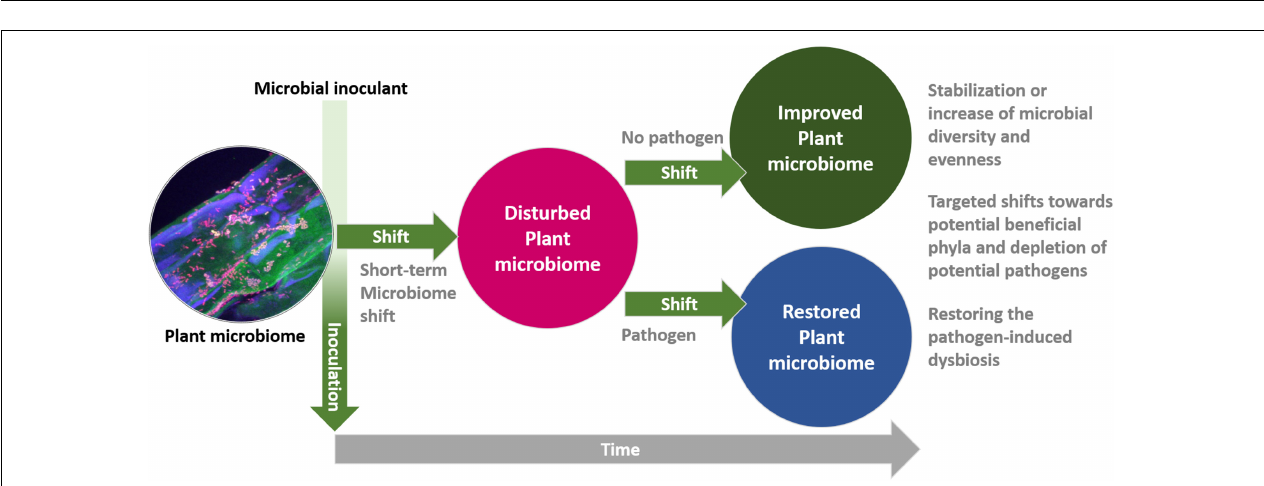
FIGURE 1 | Summary of known effects elicited by microbial inoculants on pathogens, plants and the plant-associated microbiome. Various effects of inoculants on native plant microbiomes are connected to their modes of actions related to plant health and disease prevention. The included 3D reconstruction of a micrograph shows the colonization of a microbial inoculant in plant tissues.